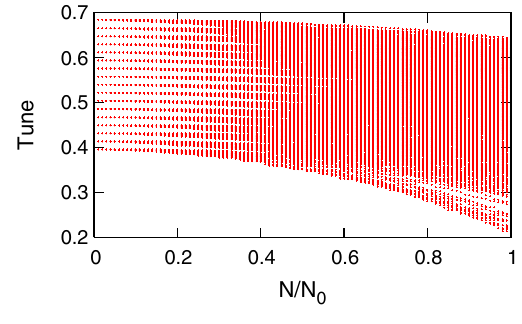
¼ 8 ; n ¼ 20 k max